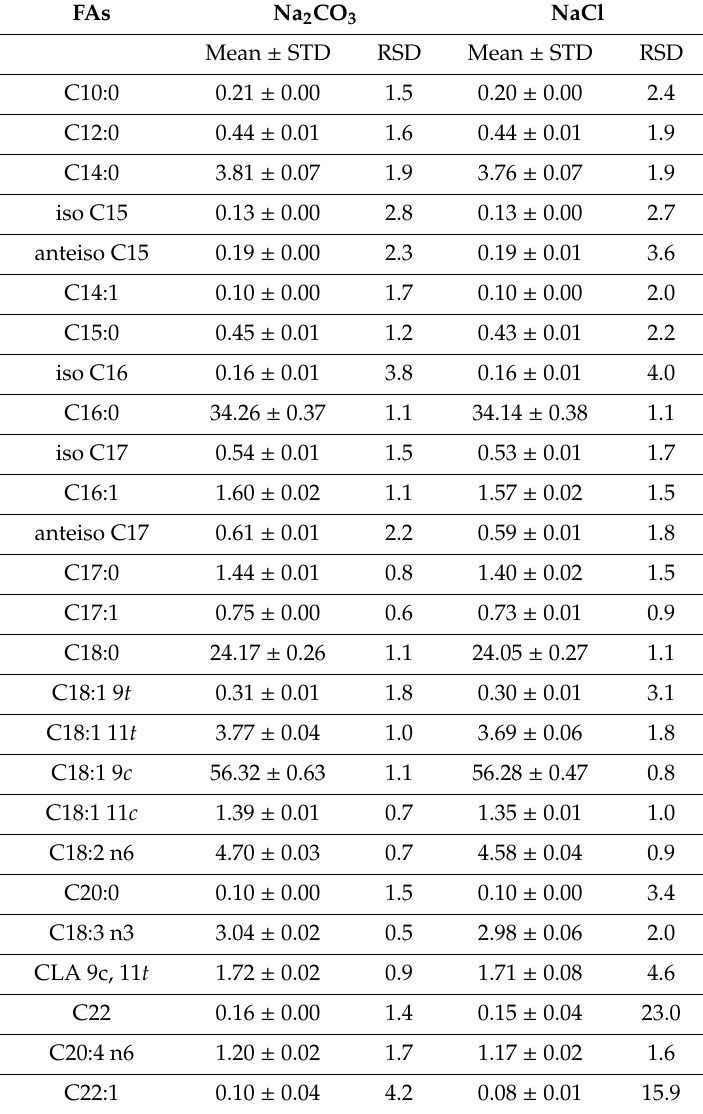
Table 2. Comparative evaluation of the e ff ect of Na 2 CO 3 and NaCl on one-step optimised method for FA analysis (mg / g dry meat) ( n =